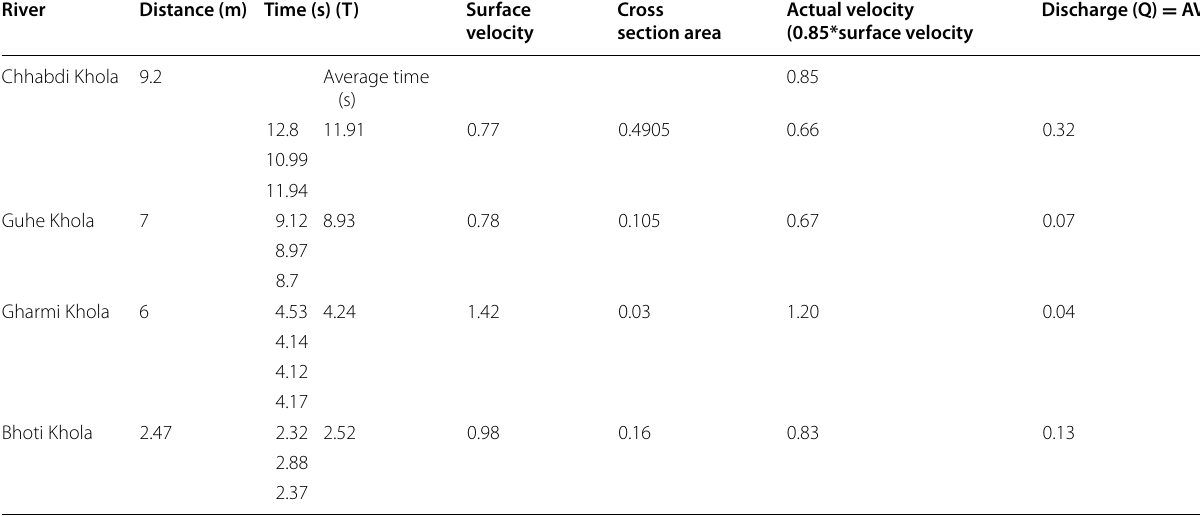
Table 8 Surface flow velocity, average cross section of river and estimated discharge in the river